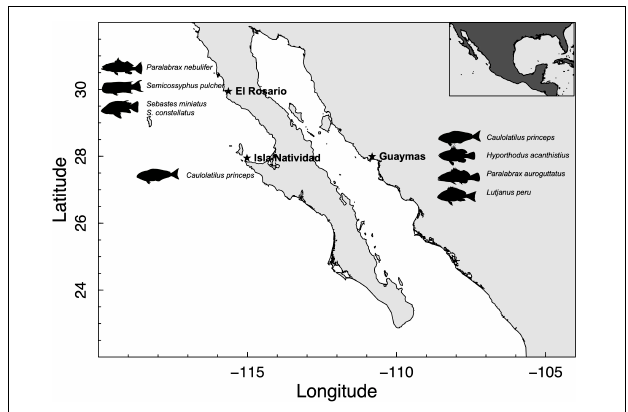
FIGURE 1 | Case studies for evaluating ecosystem impacts from artisanal fisheries showing the target species in each